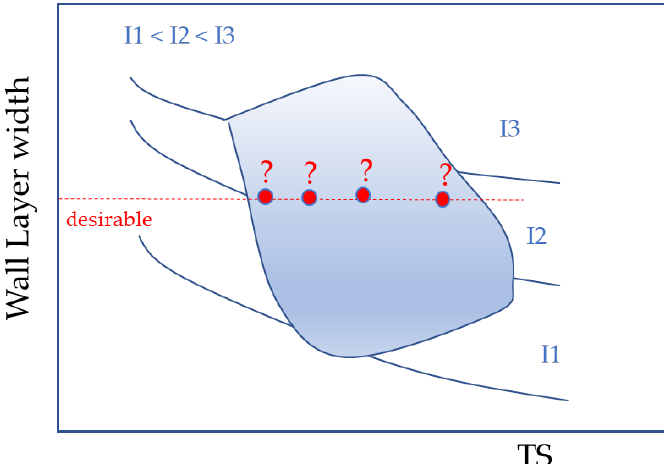
Figure 3. Hypothesis of e ff ect of the process parameters on the various characteristics of the walls for a target LW.